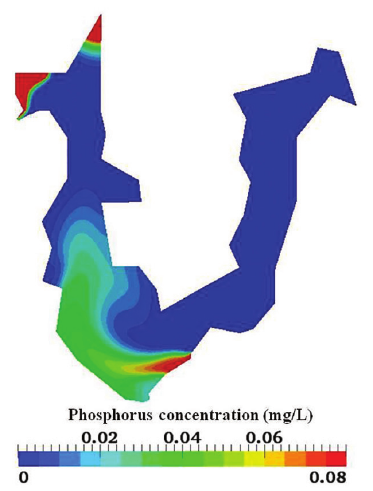
Figure 9 - Initial condition for the distribution of the total phosphorus.